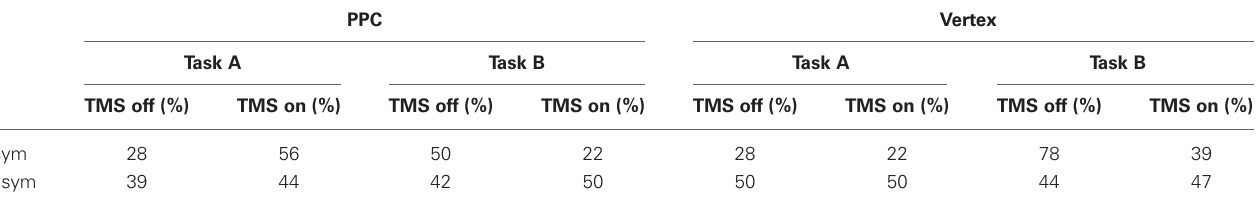
Table 1 | Percentages of right choices as a function of site (PPC, Vertex), Task (A, B) and TMS (off, on) for symmetrically (sym) and asymmetrically (asym) bisected